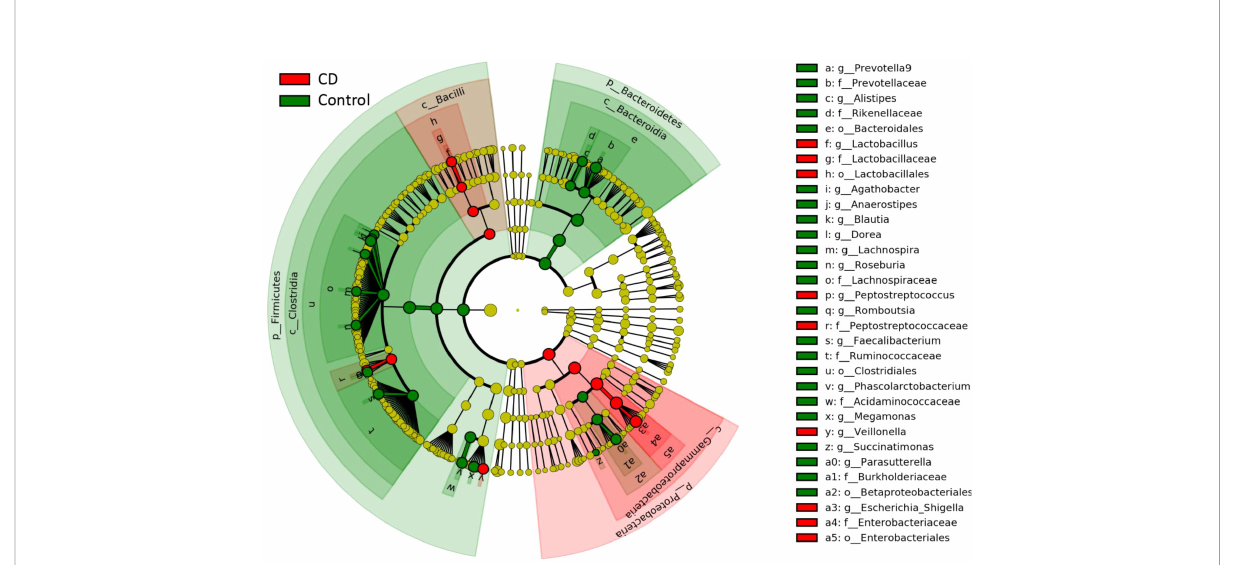
FIGURE 3 Differential gut bacterial taxa between CD and control groups. Cladogram of LEfSe linear discriminant analysis of the microbial composition comparing CD patients and controls with 16S rDNA sequencing data. Red and green indicate taxa enriched in CD or control group, respectively. The diameter of each circle is proportional to the relative abundance of the